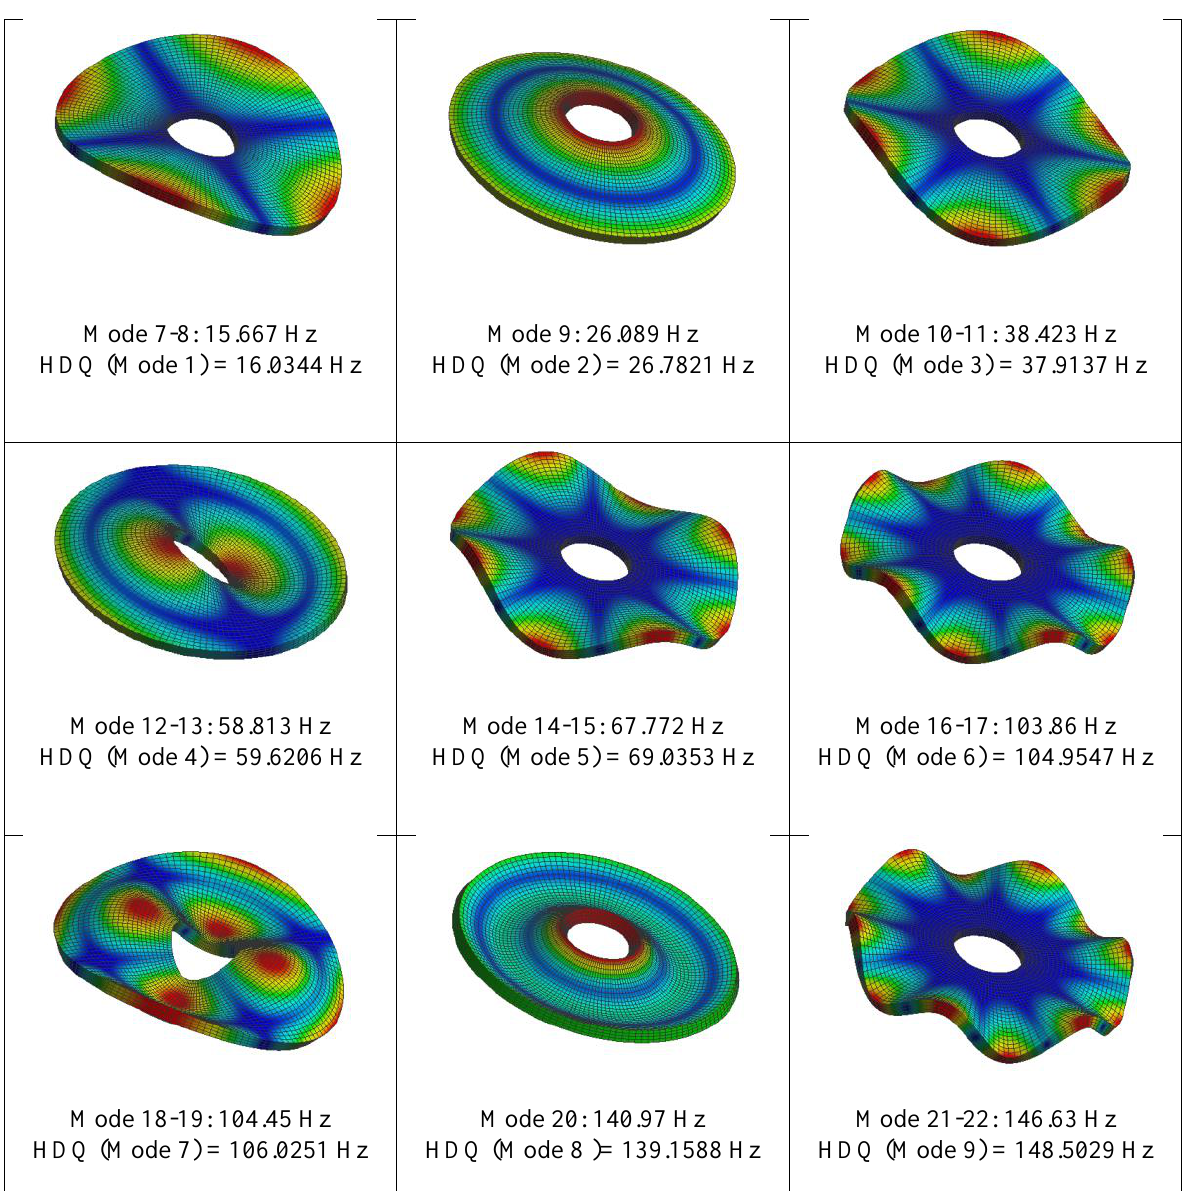
Figure 5: Frequency and mode shapes of annular plate with free edges (h=5cm, R 1 =50 cm, R 2 =200 cm, ρ =7800 kg/m 3 , E=2.1 × 10 11 Pa, ν